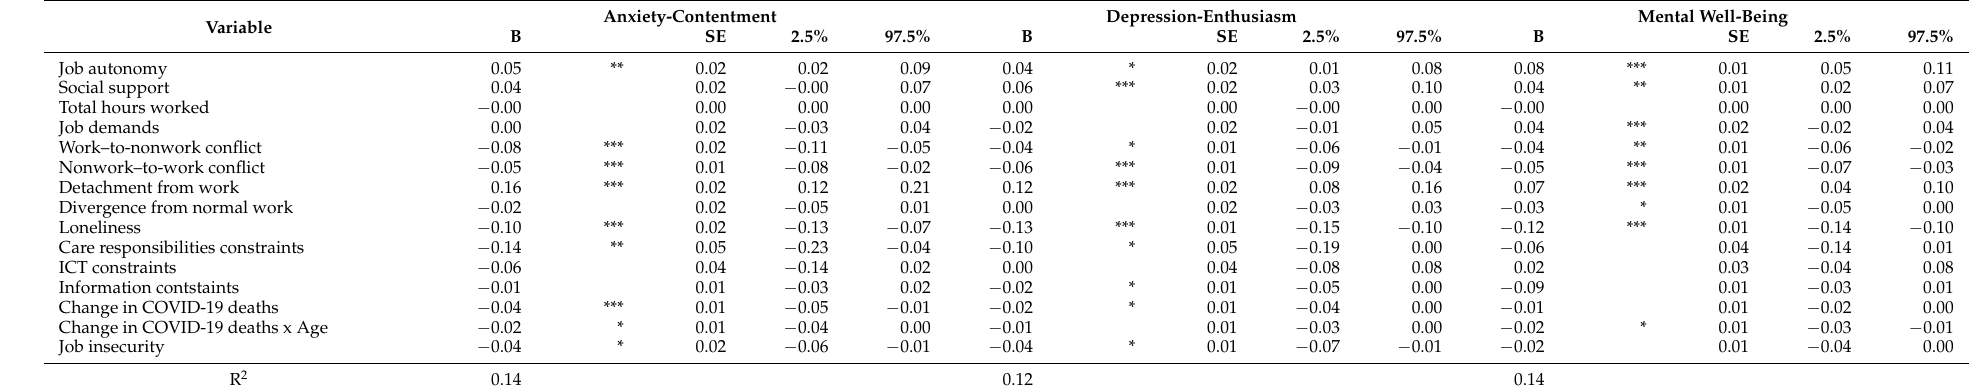
Table 4. Phase1 within-person effects on well-being.